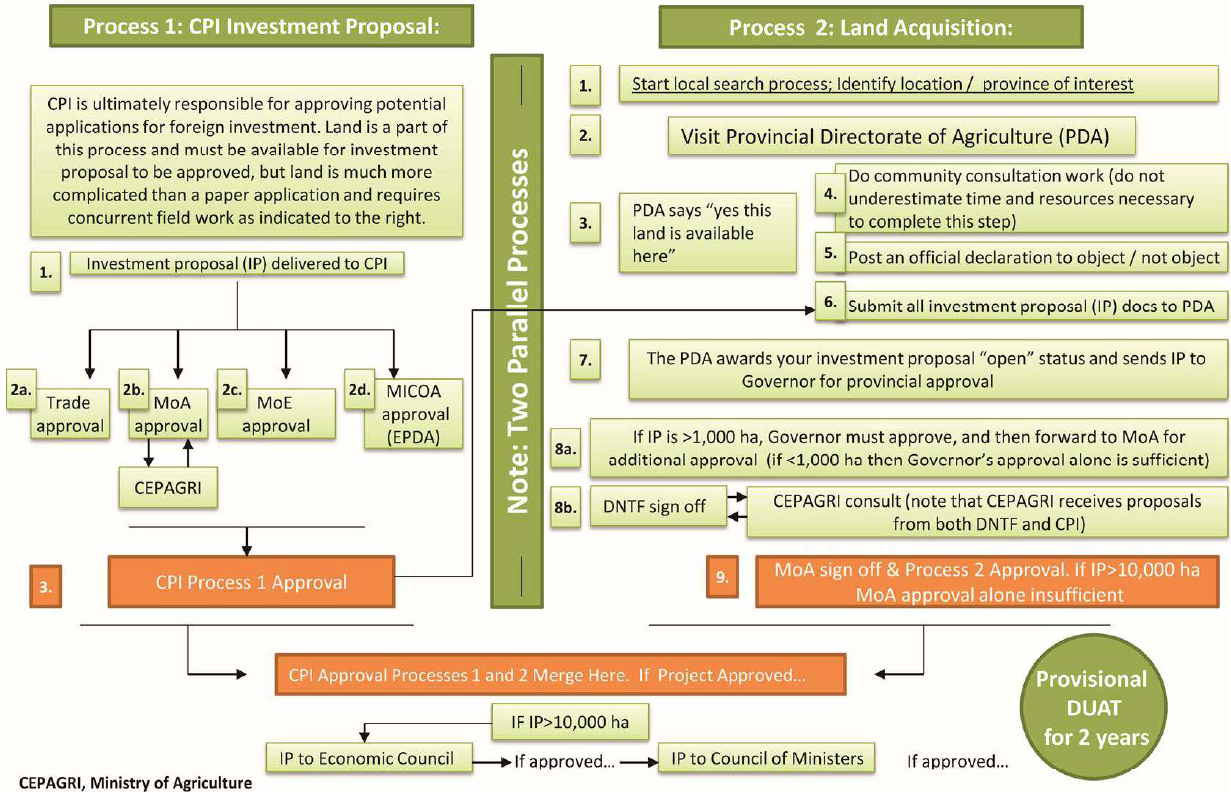
Fig. 7. Project application and land acquisition process (CEPAGRI